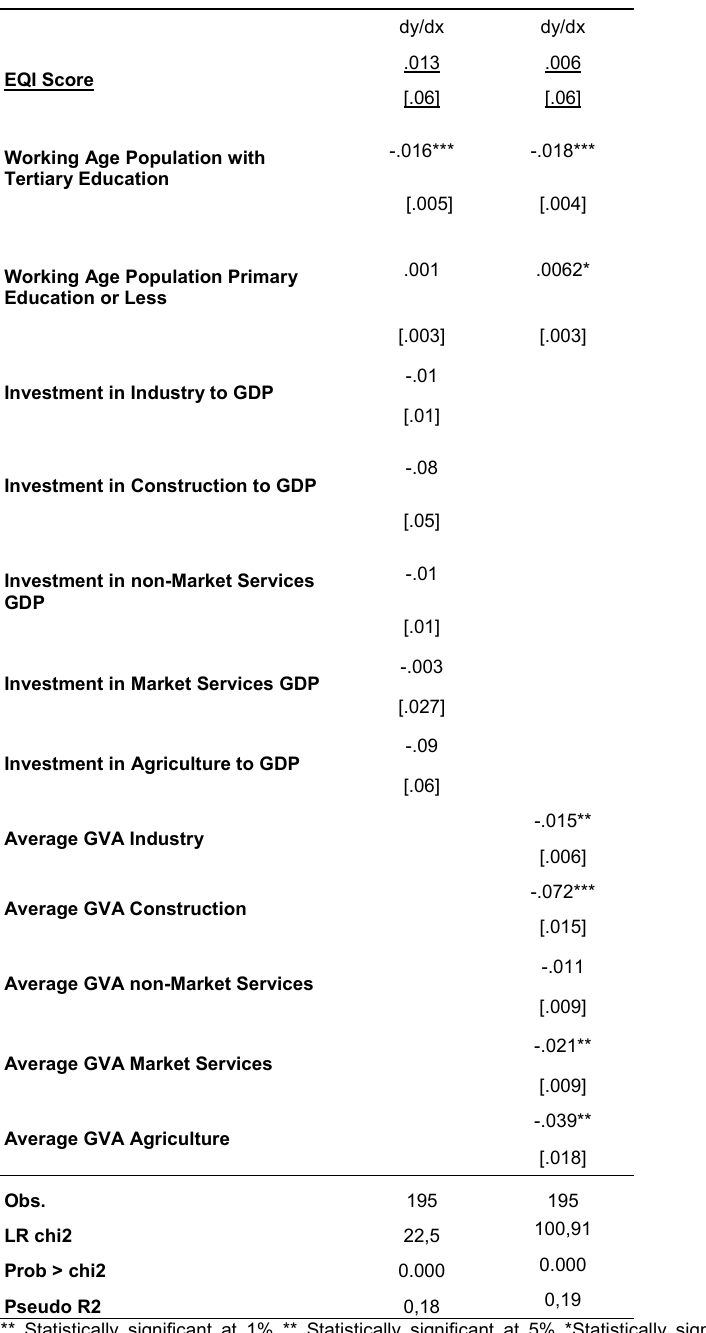
Table 8. Marginal effects on probability Y=1|X. Group B + Group D – robustness